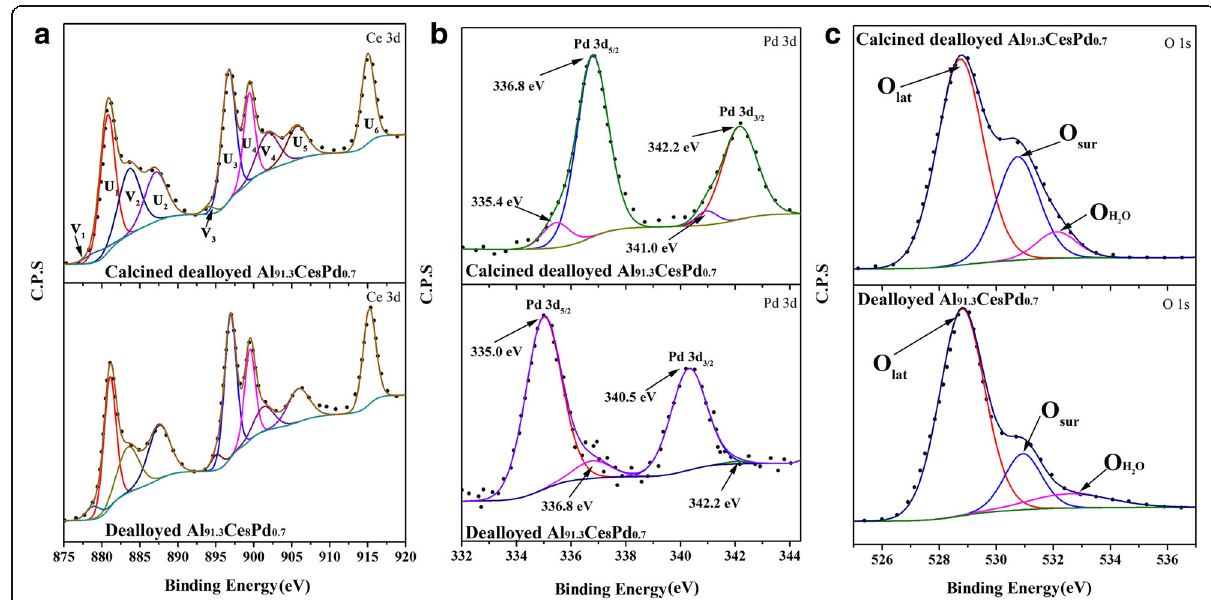
Fig. 6 XPS spectra of the Ce 3d ( a ), Pd 3d ( b ), and O 1s ( c ) regions of the dealloyed Al 91.3 Ce 8 Pd 0.7 sample and the dealloyed Al 91.3 Ce 8 Pd 0.7 sample calcined at 400 °C